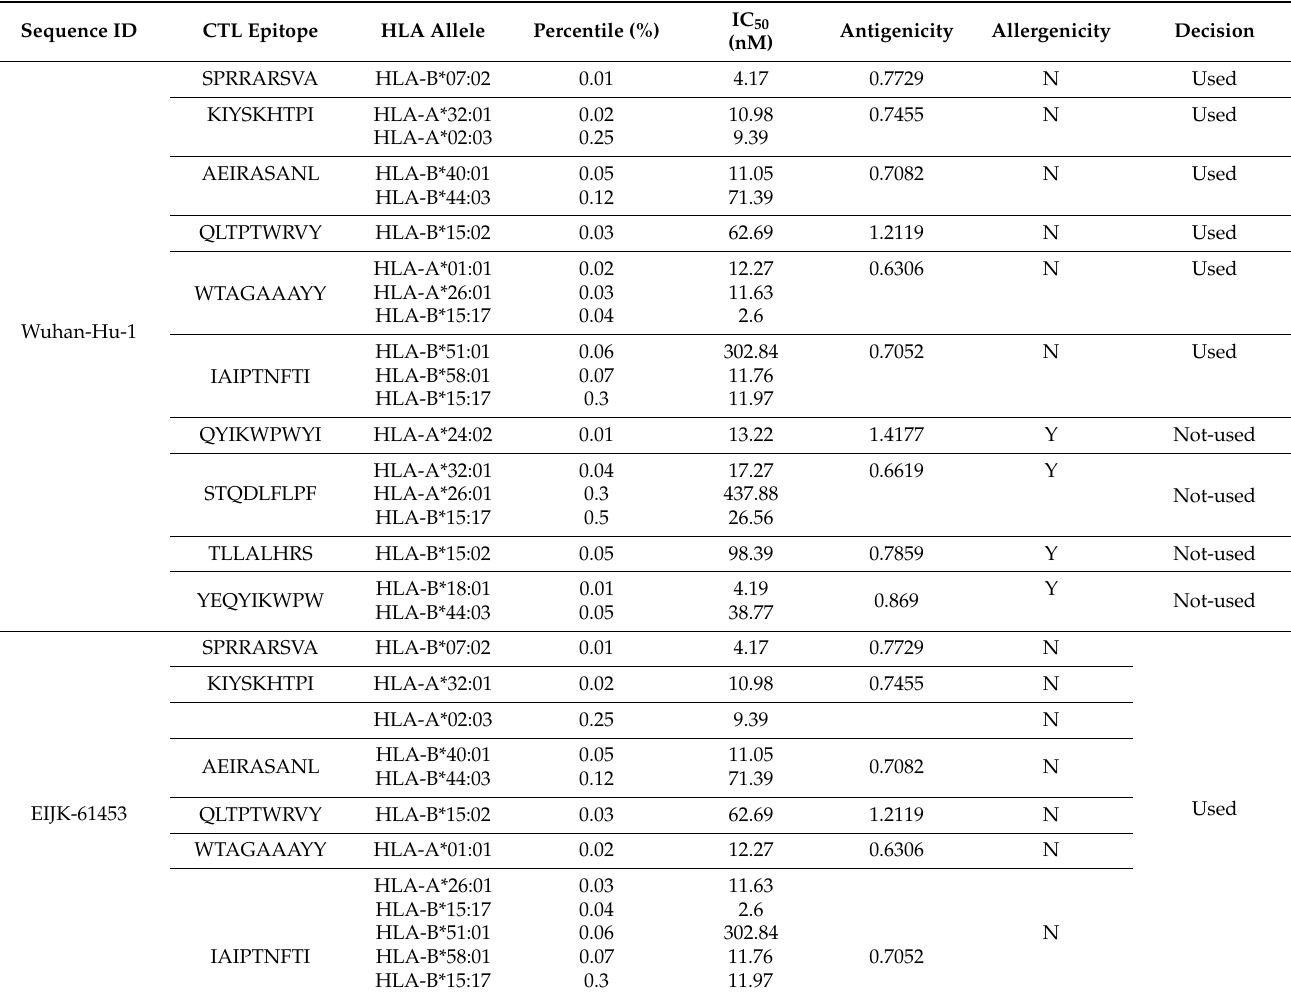
Table 3. Selected epitopes from the CTL